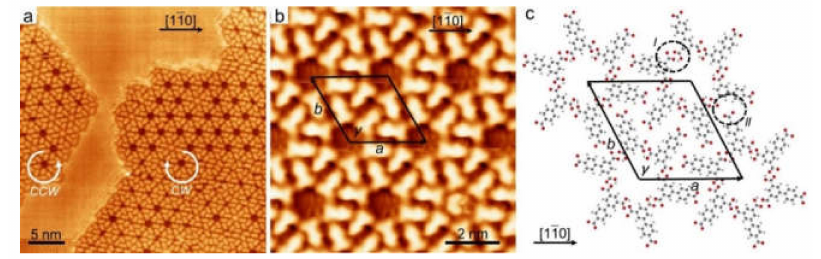
Figure 3. H1 structure after a 470 K annealing. ( a ) An STM overview ( U = − 0.6 V, I = 50 pA) of H1 structure containing both CCW and CW domains. ( b , c ) High-resolution STM image ( U = − 0.6 V, I = 200 pA) of a CW H1 structure and the corresponding tentative structural mode. Ovals indicate the two intermolecular bonding